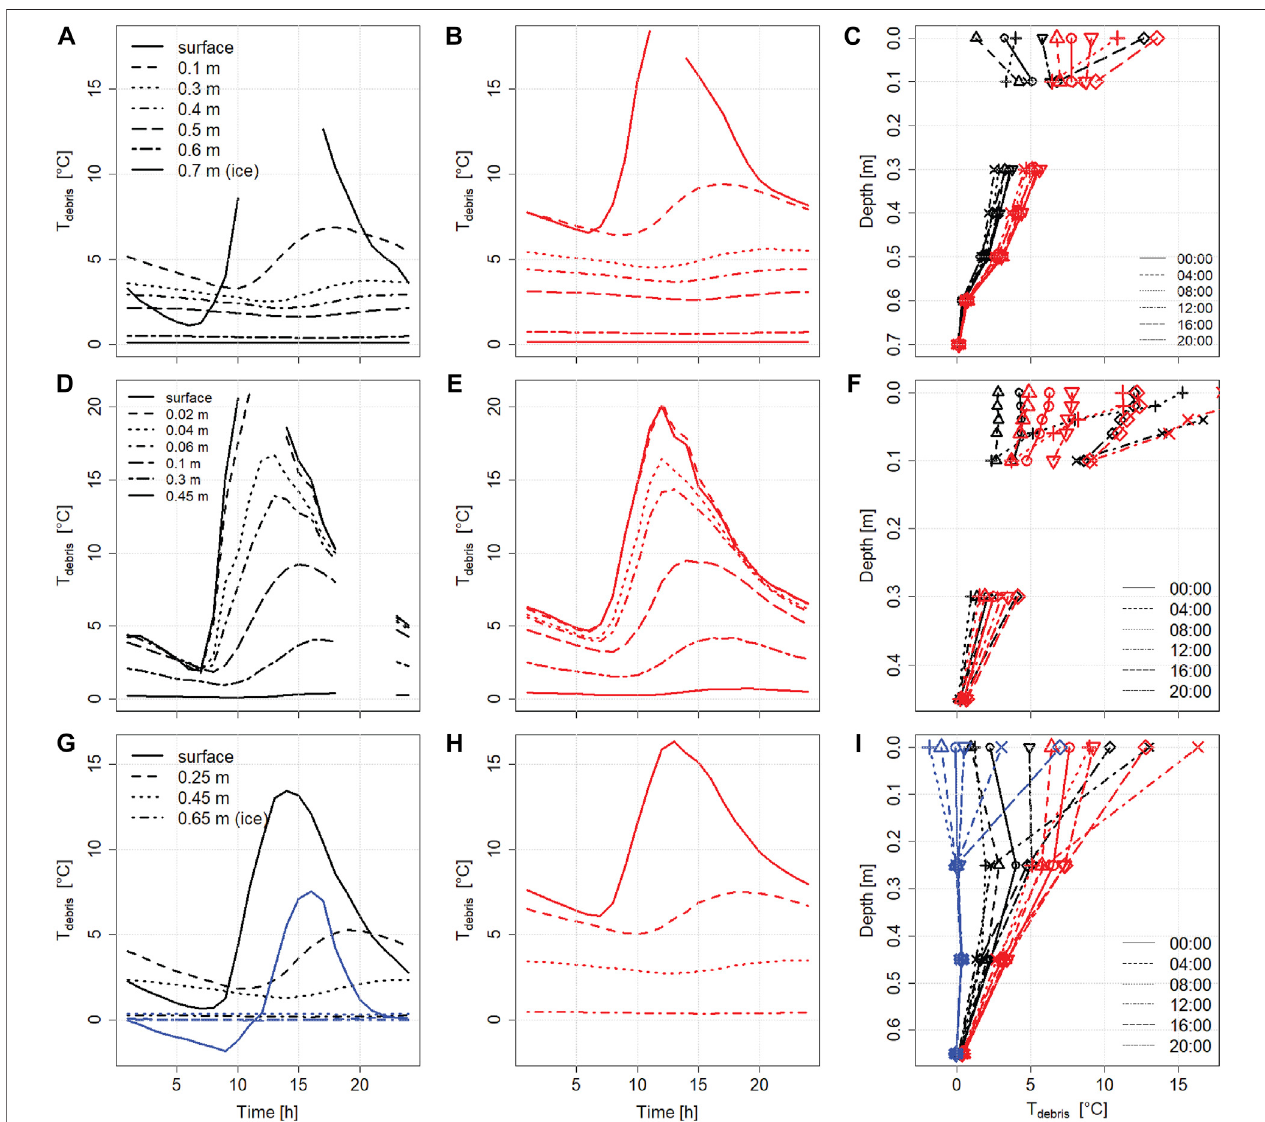
FIGURE 4 | Temperature pro fi les in debris measured at the AWS in 2012 [ (A – C) , LIR1], 2013 [ (D – F) , LIR2] and from 2017 [ (G – I) , LIR3]. Blue is the winter season (1st January to 28th February), red the wet season (06/15 to 09/19) and black the dry seasons.